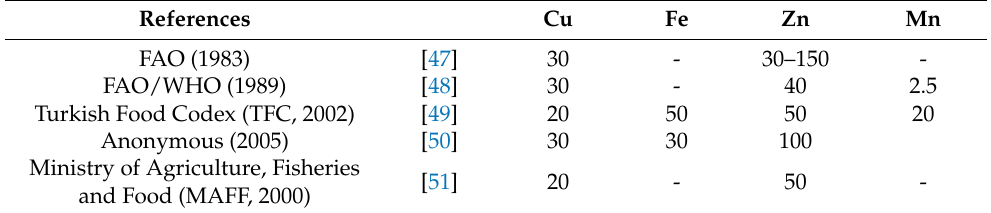
Table 4. Permitted levels of heavy metals in fish (mg/kg wet weight) described in the different